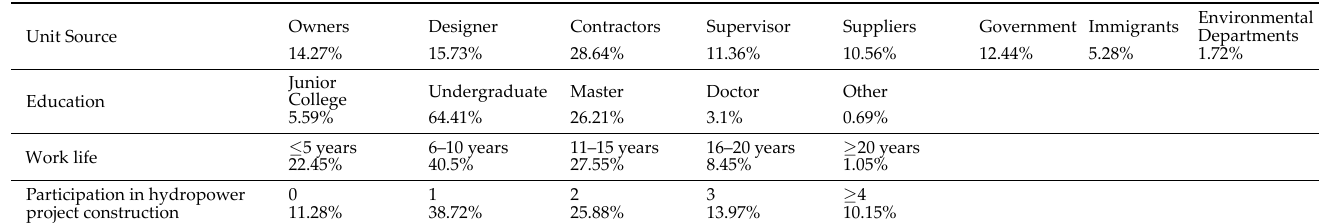
Table 5. Background information for